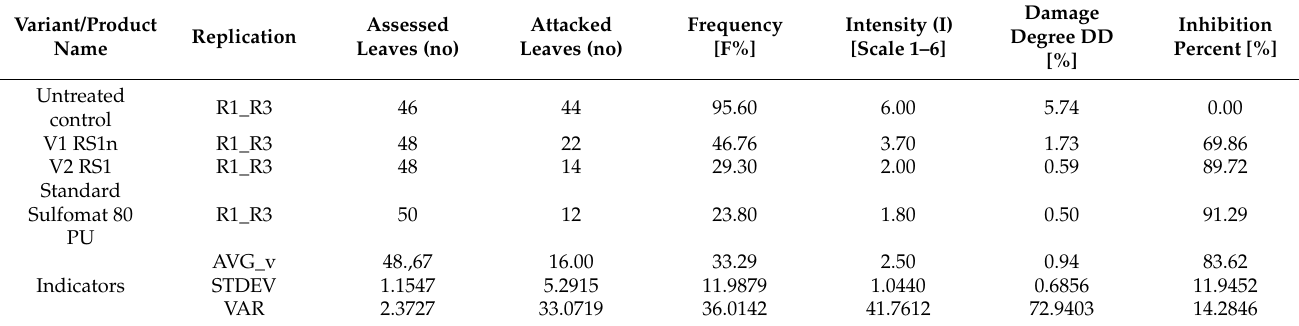
Table 4. Effect of vegetal extracts in control of powdery mildew— Podosphaera leucotricha.